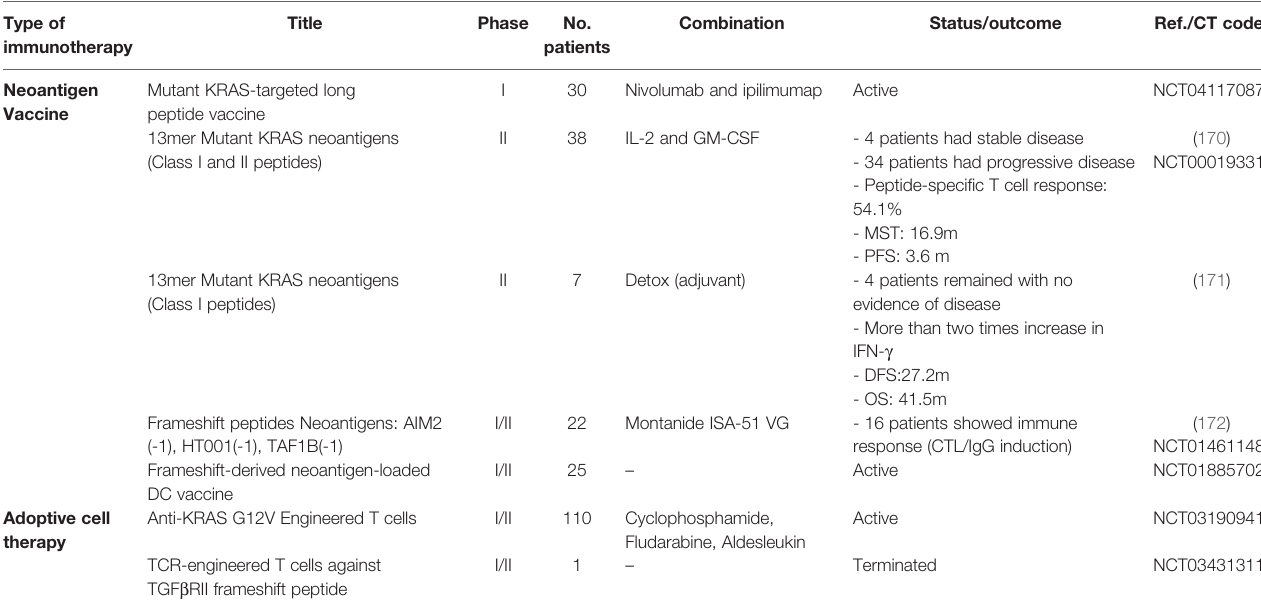
TABLE 1 | Clinical trials on CRC immunotherapy targeting shared neoantigens. Type of